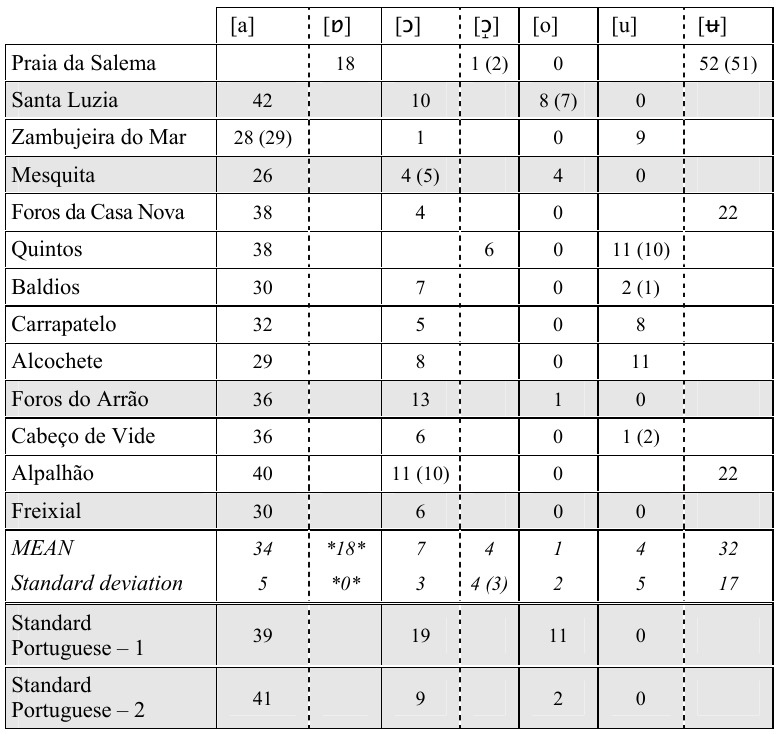
Table II. Percent of the acoustic space of F2 of non-front vowels in the respective phonological